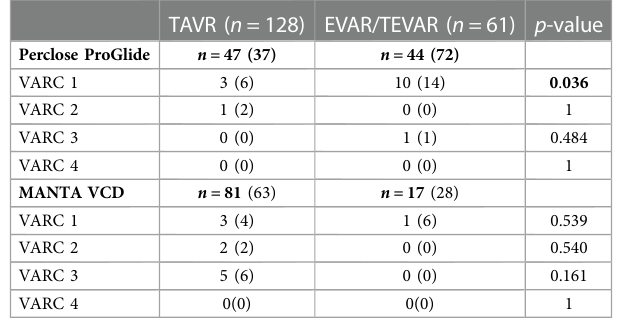
TABLE 6 VARC-3 bleeding complications comparison by the type of procedures.